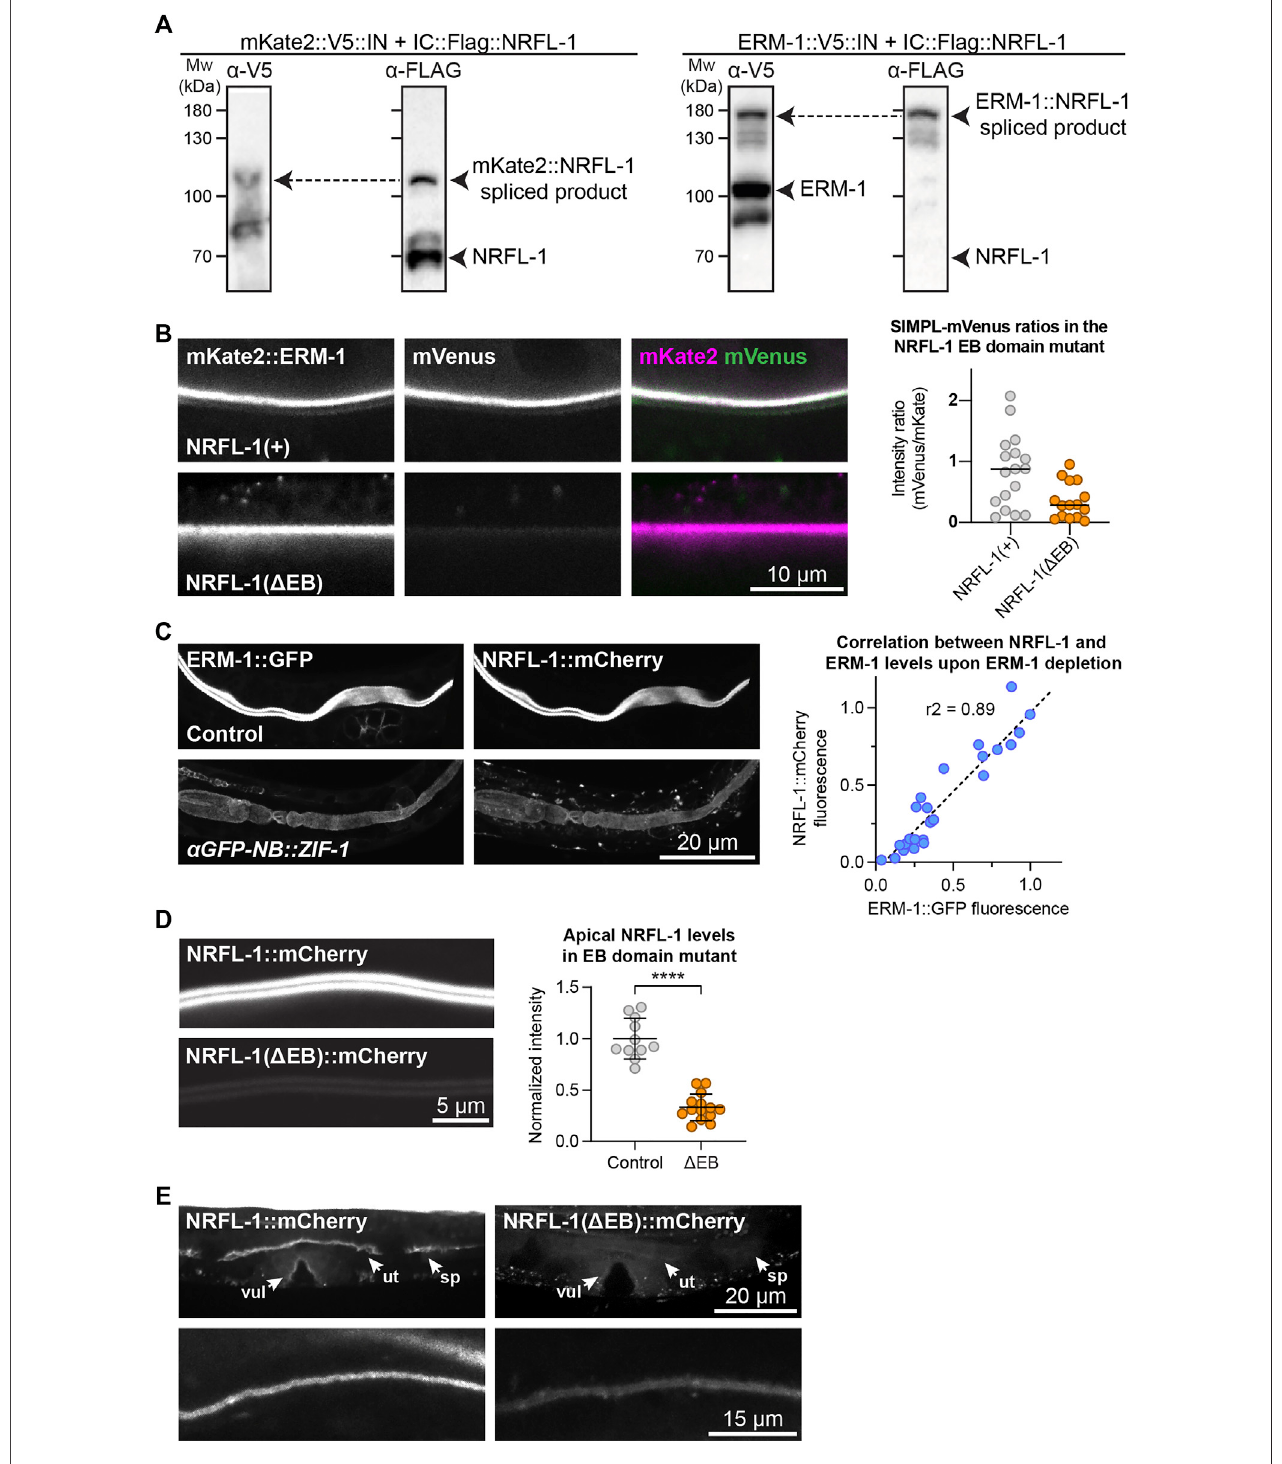
FIGURE 2| NRFL-1 localizes to the apical domain through ERM-1 binding. (A) Detection of an ERM-1 – NRFL-1 interaction using the SIMPL system. V5and FLAG epitopes are detected by western blot. Arrowheads indicate both unspliced proteins and the higher molecular weight covalently linked fusion proteins, generated by Intein splicing activity. Little splicing of NRFL-1 is observed with the control mKate2::V5::IN protein, while all NRFL-1 is spliced to ERM-1 in animals expressing ERM-1:: V5::IN (B) Detection of an interaction of ERM-1 with wild-type NRFL-1, but not with NRFL-1( Δ EB), using the SIMPL-mVenus system. NRFL-1a::InteinC-3xFLAG- VC155 [NRFL-1(+)] or NRFL-1a( Δ EB)::InteinC-3xFLAG-VC155 [NRFL-1( Δ EB)] are expressed with mKate2::ERM-1::VN155-HA-V5-InteinN (mKate2::ERM-1).